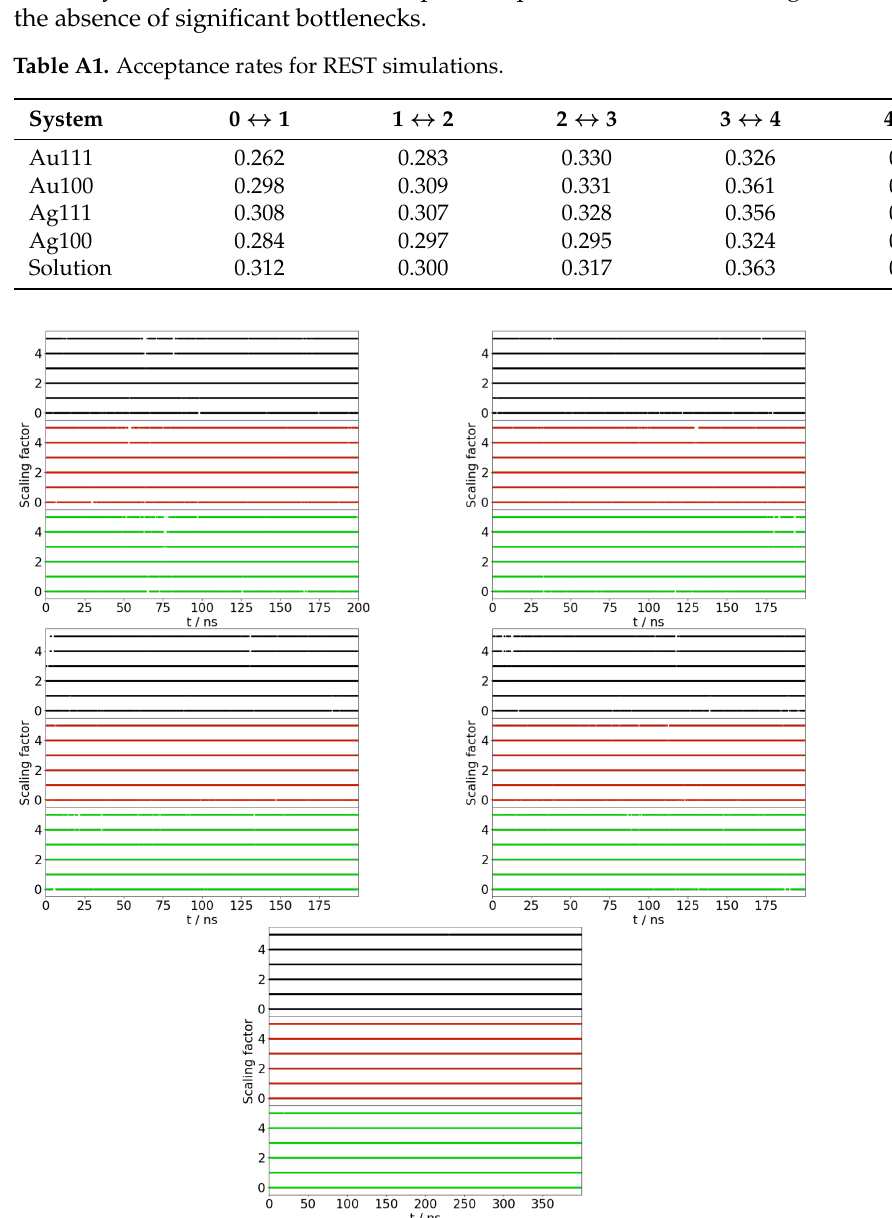
Figure A1. Plot of scaling factor ( i denotes β i ) for REST simulations. Graphs show Au111 ( top left ), Au100 ( top right ), Ag111 ( middle left ), Ag100 ( middle right ), and bulk solution ( bottom ). Graphs show replicas with i = 0 (black), 3 (red), and 5 (green) at t =